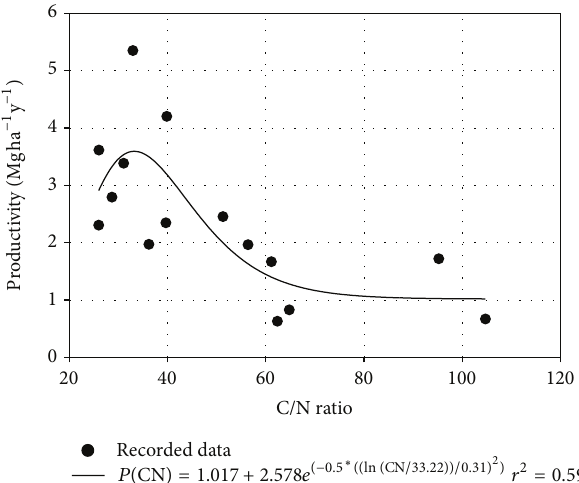
Figure 3: The relationship between aboveground productivity and C/N ratio for five geoforms established in the Tamaulipan thornscrub forests of northeastern Mexico.